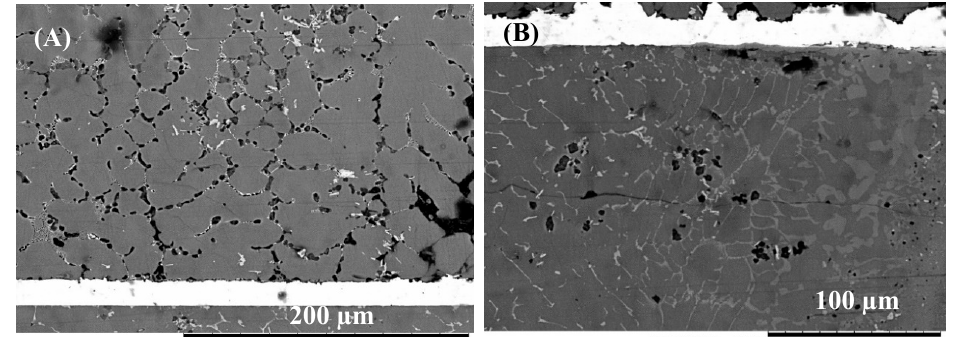
Figure 8. ( A ) SEM micrograph of Mg/Al bonded for 2 min using Cu /Al 2 O 3 interlayer: ( B ) Detail view of the interface.